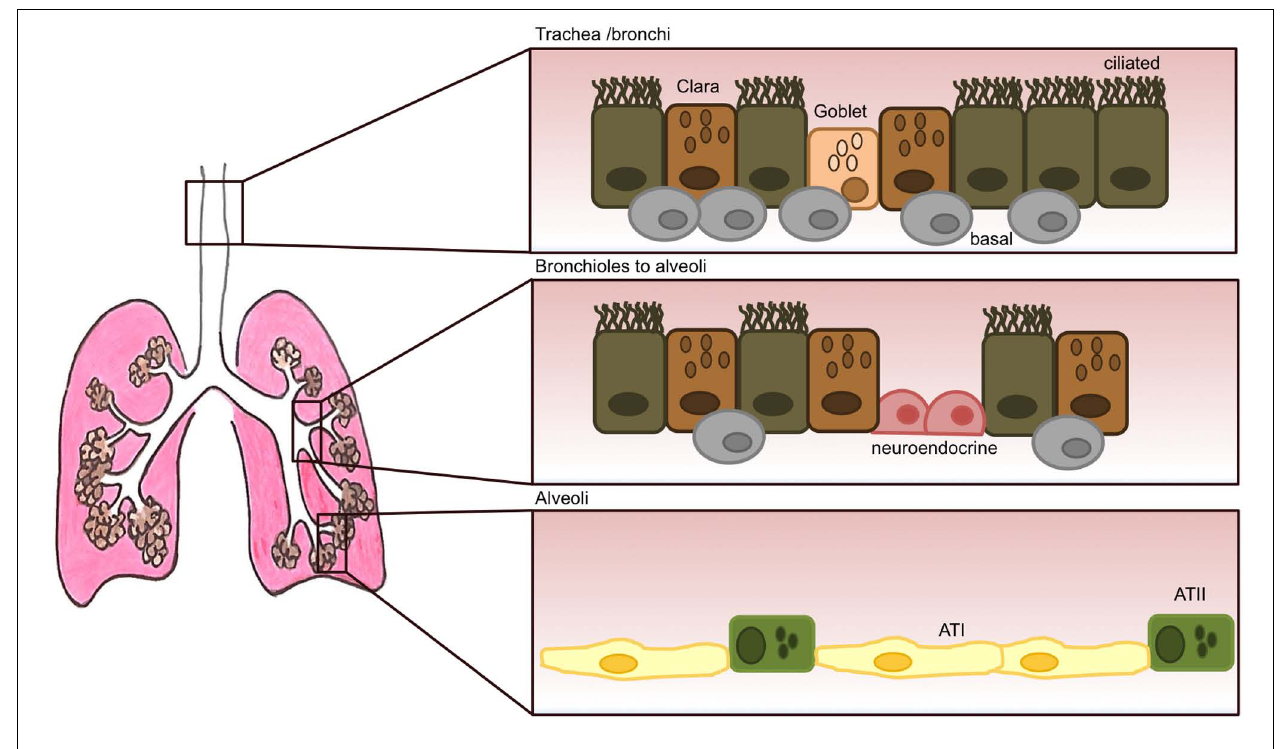
dramatically as the lung progresses into the alveolar space. Neuroendocrine cells can also be present that become innervated by ganglion cells.Their role is thought to be of regulating cell proliferation and differentiation.The respiratory bronchioles are still very poorly characterized and lead to the alveoli, that are mostly lined by alveolar type I (ATI) and type II (ATII)